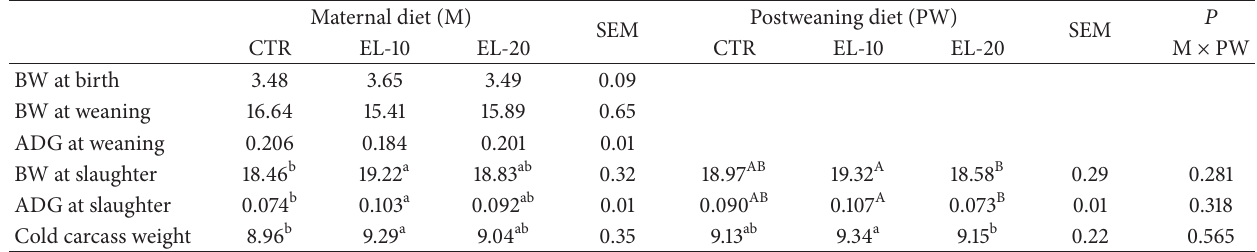
Table 3: Effect of maternal and lamb postweaning diets on body weight (BW, kg), average daily gain (ADG, kg/die), and cold carcass weight of light Sarda lambs.